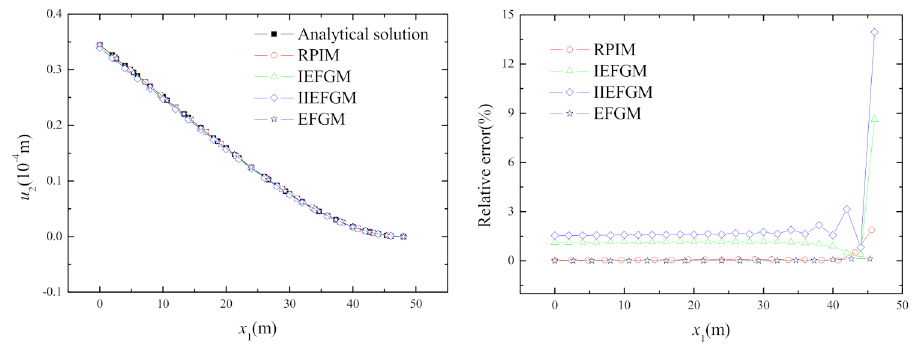
Figure 6. The nodes deflection and its relative error at central axis.